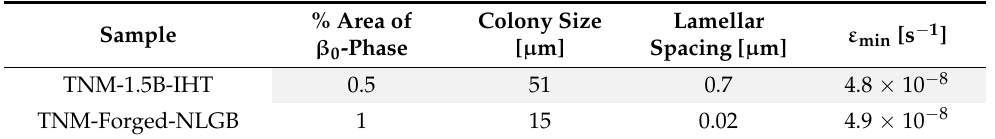
Table 4. Comparison of microstructural and mechanical properties of both novel modified TNM IHT and conventional TNM-Forged.